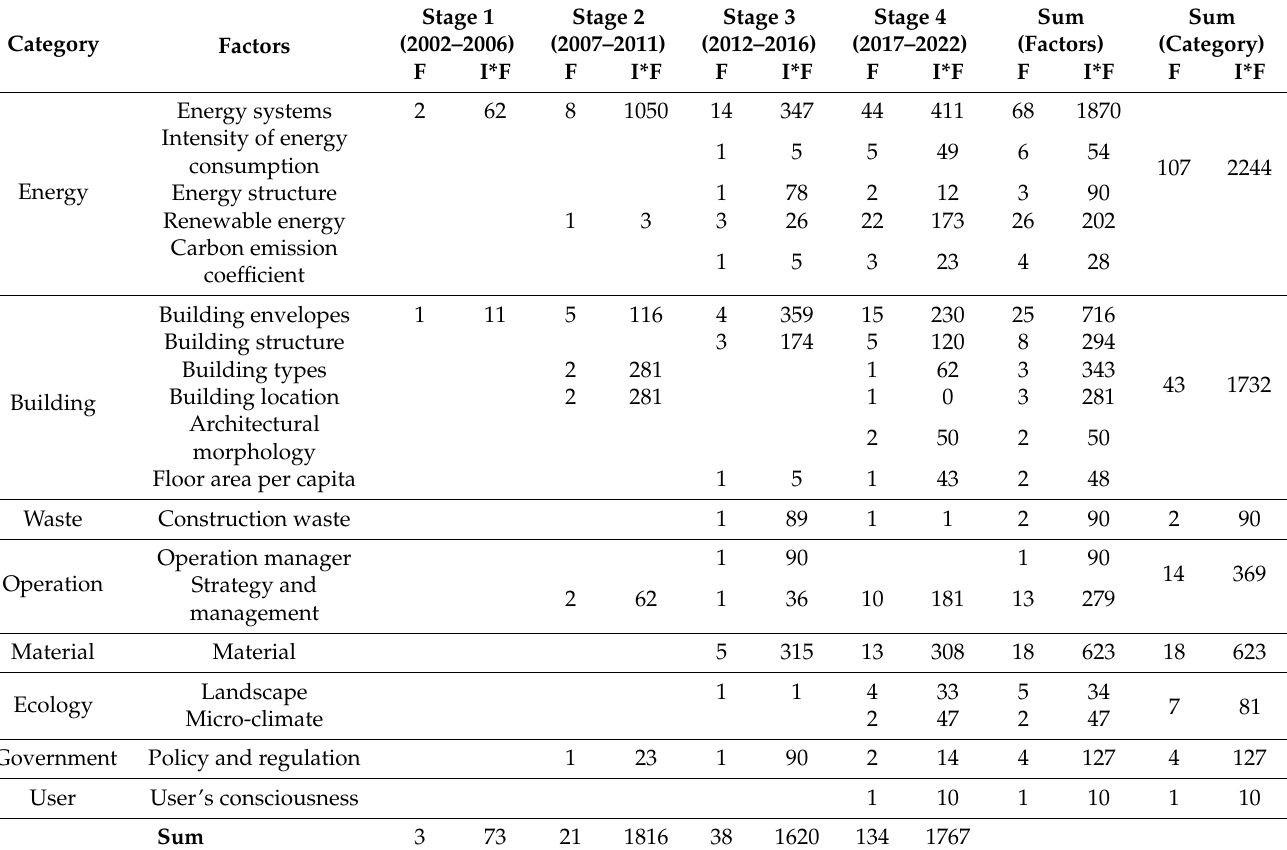
Table 6. The main factors that contribute to the reduction in